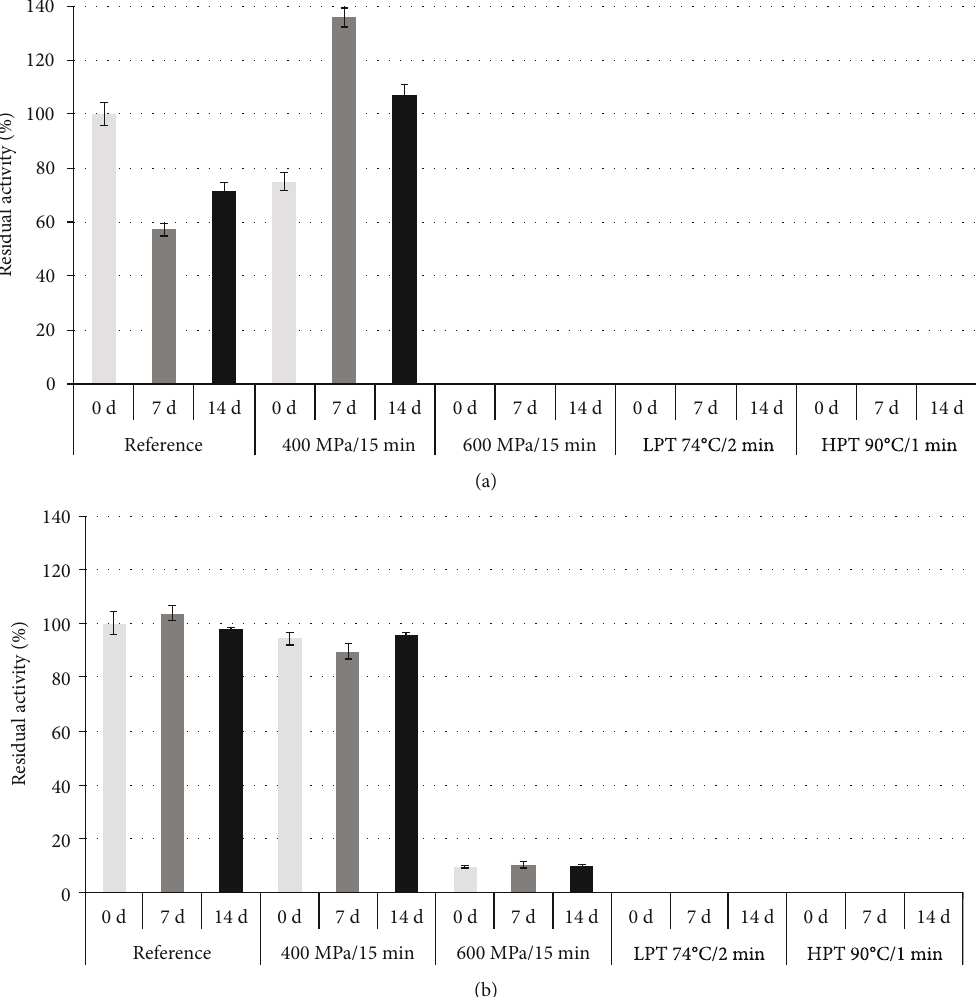
Figure 1: Activity of PPO (a) and POD (b) as analysed in the untreated, HHP-treated, and pasteurized (LPT and HPT) tomato juice after 0, 7, Þ · 100 ) are presented, where A and 14 days of storage. The (%) residual activities ( ð A / A represents the initial enzyme activity determined in 0 0 freshly prepared juice ( Δ OD/min/g fw). Vertical bars indicate standard deviations of the means ( n = 3 ). ∗ ND: not